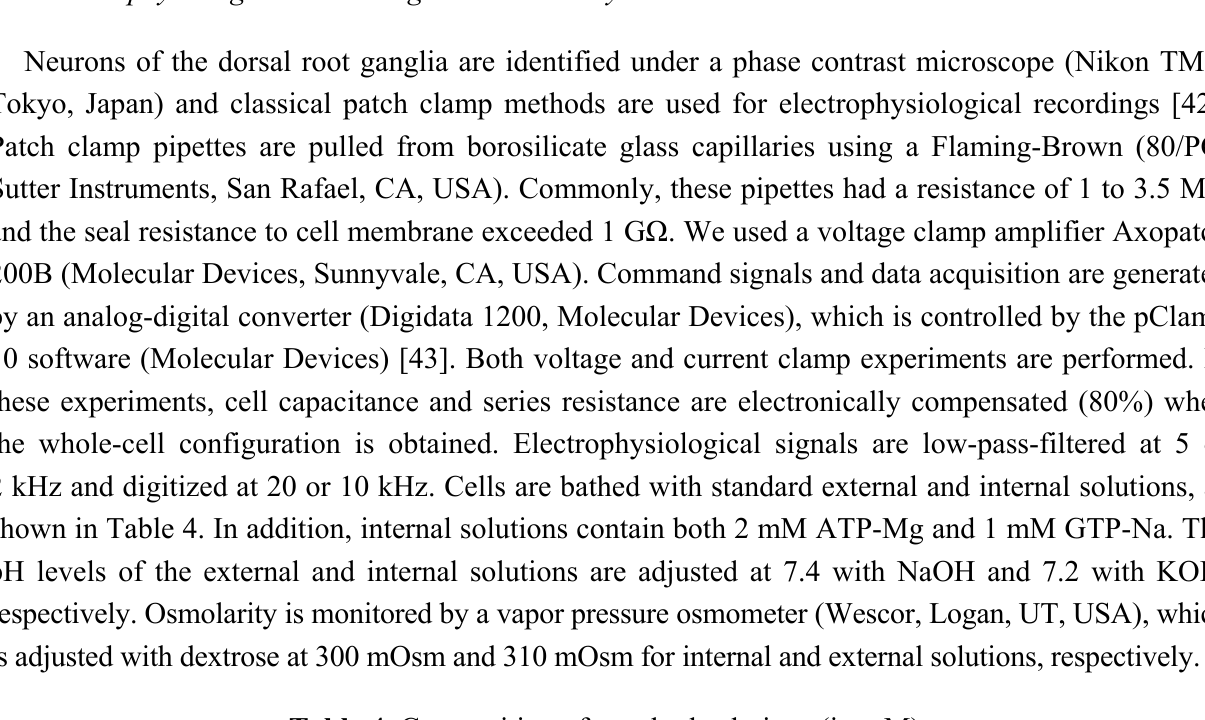
Table 4. Composition of standard solutions (in